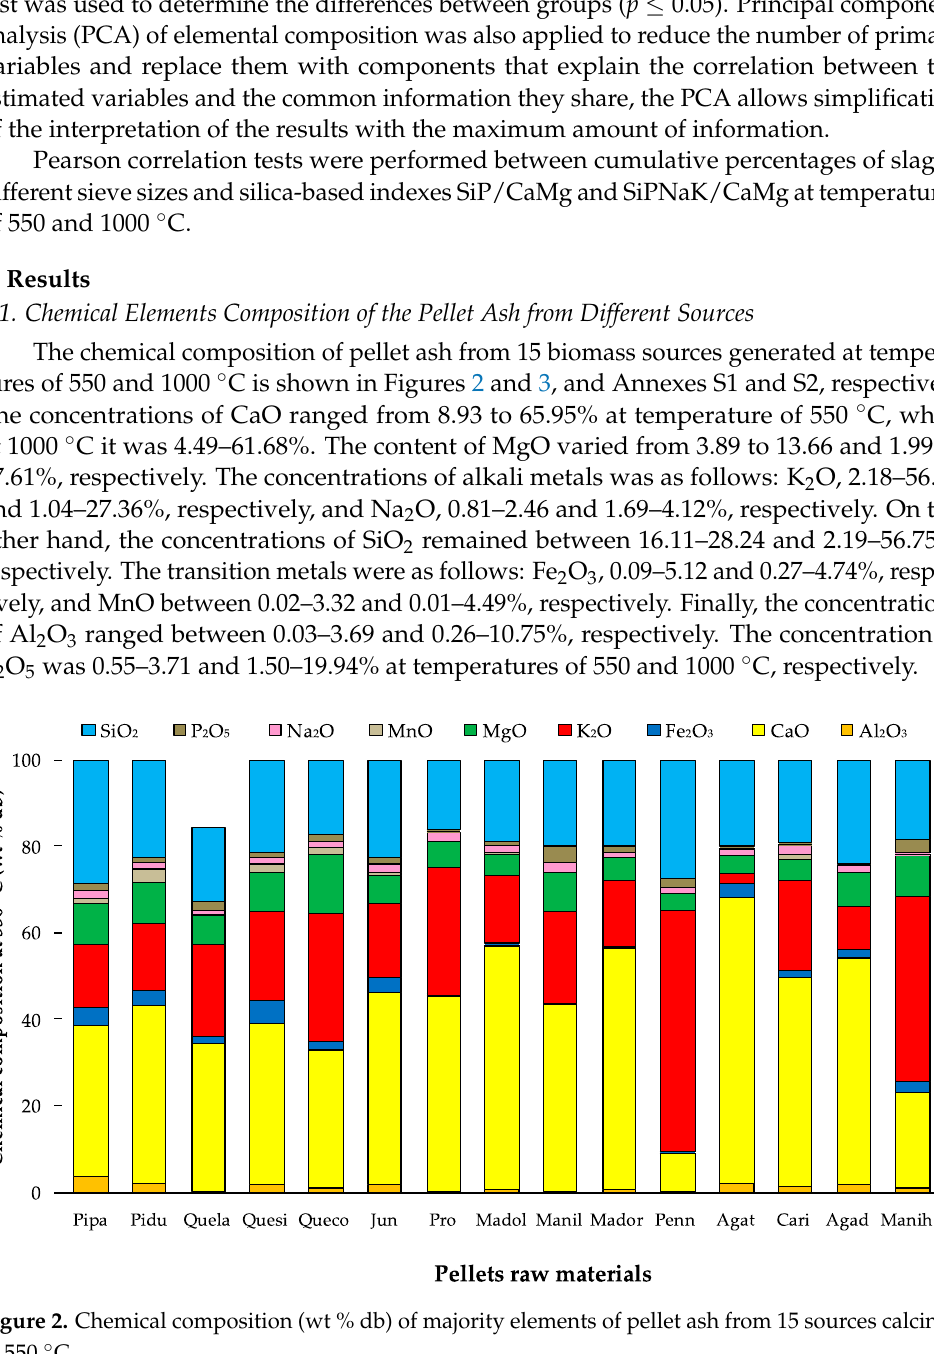
Figure 3. Chemical composition (wt % db) of majority elements of pellet ash from 15 sources sub- jected to calcination at 1000 °C. Figures 4 and 5 show the relationships between the concentrations of elements and the pellet sources evaluated by principal component analysis at 550 °C and 1000 °C, re- spectively. The PCA at 550 °C shows a negative correlation in PC1 and PC2 between the elements P 2 O 5 and K 2 O for Penn, Manih and Queco pellets. It can be observed that con- centrations of MgO, MnO, SiO 2 , Fe 2 O 3 , and Al 2 O 3 were positively correlated with PC1 and negatively with PC2. In addition, the concentration of these elements presents similar trend for Pipa, Pidu and Quesi pellets. The concentration of CaO and Na 2 O were posi- tively correlated with PC1 and PC2 for Agad, Agat and Cari pellets. Finally, it can be ob- served that Manil, Madol, Mador and Pro pellets were negatively correlated with PC1 and positively with PC2. It was observed that the concentrations of the elements P 2 O5 and K 2 O, MnO and SiO 2 and CaO and Na 2 O have a high correlation value, while CaO and Fe 2 O 3 , SiO 2 and P 2 O 5 were not correlated.